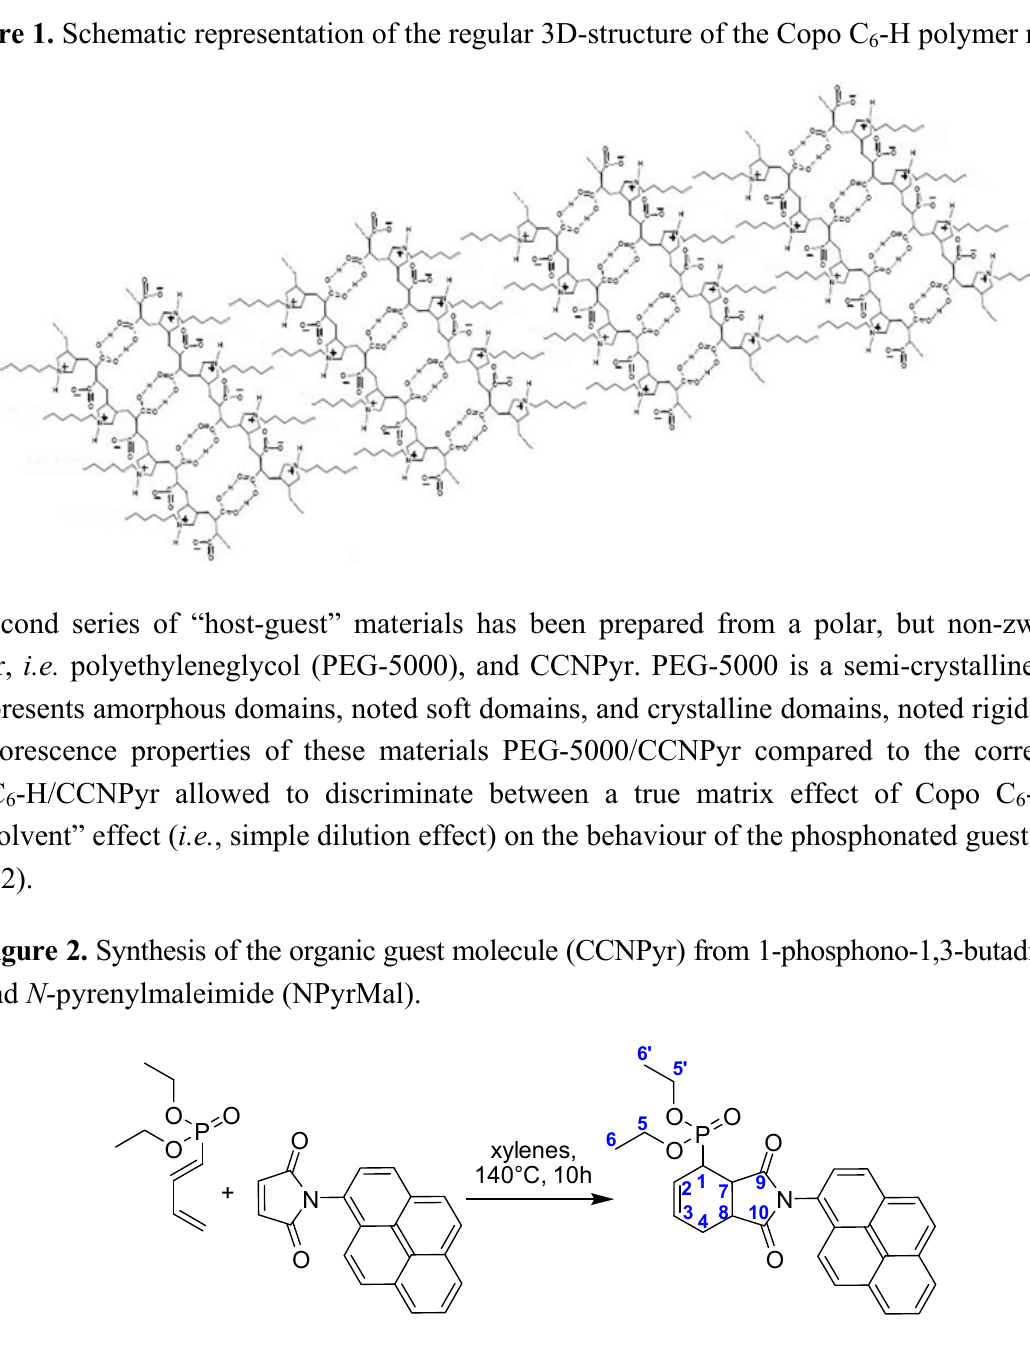
Figure 1. Schematic representation of the regular 3D-structure of the Copo C